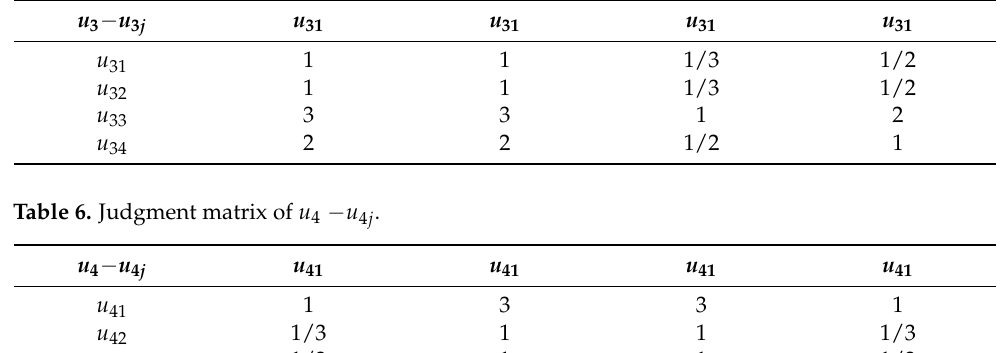
Table 5. Judgment matrix of u 3 − u 3 j .